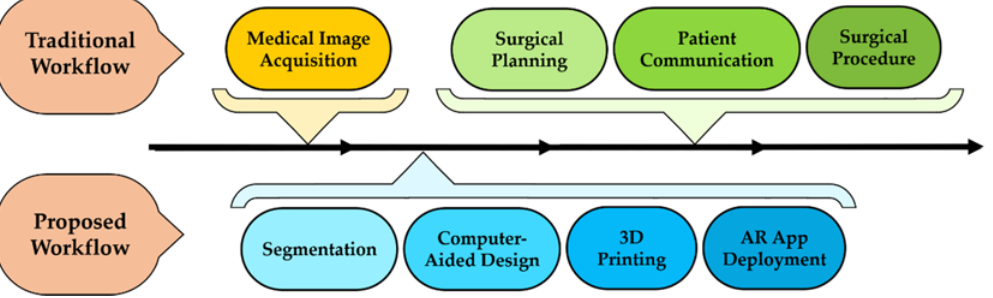
Figure 1. Prosed step by step orthopedics oncology medical workflow.